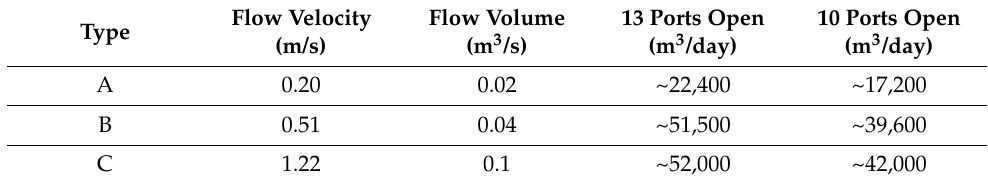
Table 1. Flow rate results for Cases A, B and